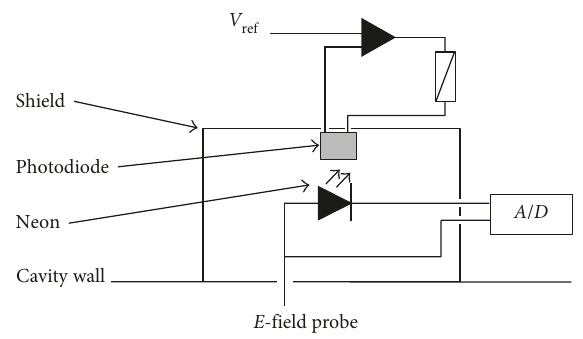
Figure 6: Schematic of the E- probe circuit, showing a neon dis- charge lamp, a photodiode, and an analogue-to-digital